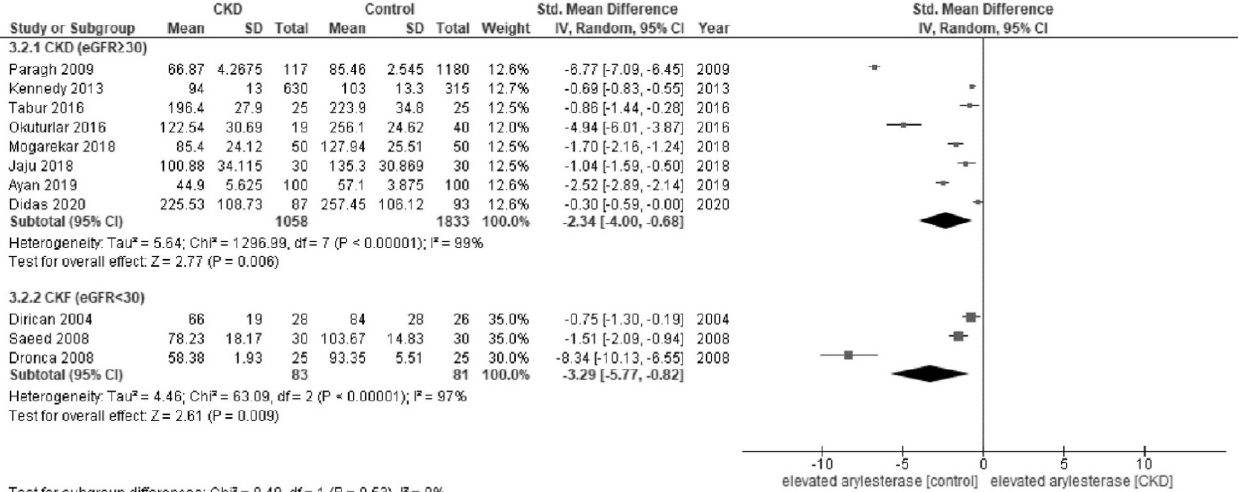
Figure 5. Forest plot of arylesterase activity stratified by the CKD stages [28,30,32,34,39,41–43,45–47].